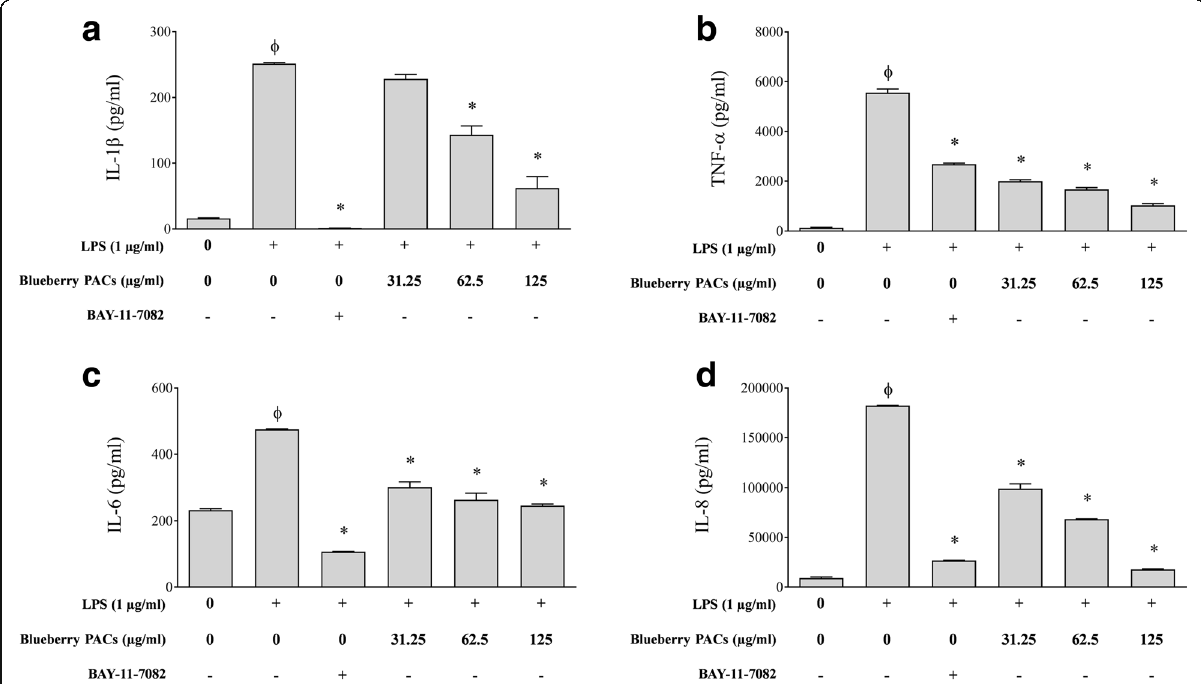
Fig. 6 Effect of highbush blueberry PACs on the secretion of a IL-1 β , b TNF- α , c IL-6, and d CXCL8 by macrophages stimulated with A. actinomycetemcomitans LPS . The commercial inhibitor BAY-11-7082 (25 μ M) was used as a positive inhibitory control. Results are expressed as the means ± SD of triplicate assays from three independent experiments. Φ : significant increase ( p <0.001) compared to unstimulated control cells. *: significant decrease ( p <0.001) compared to LPS-stimulated cells not treated with highbush blueberry PACs